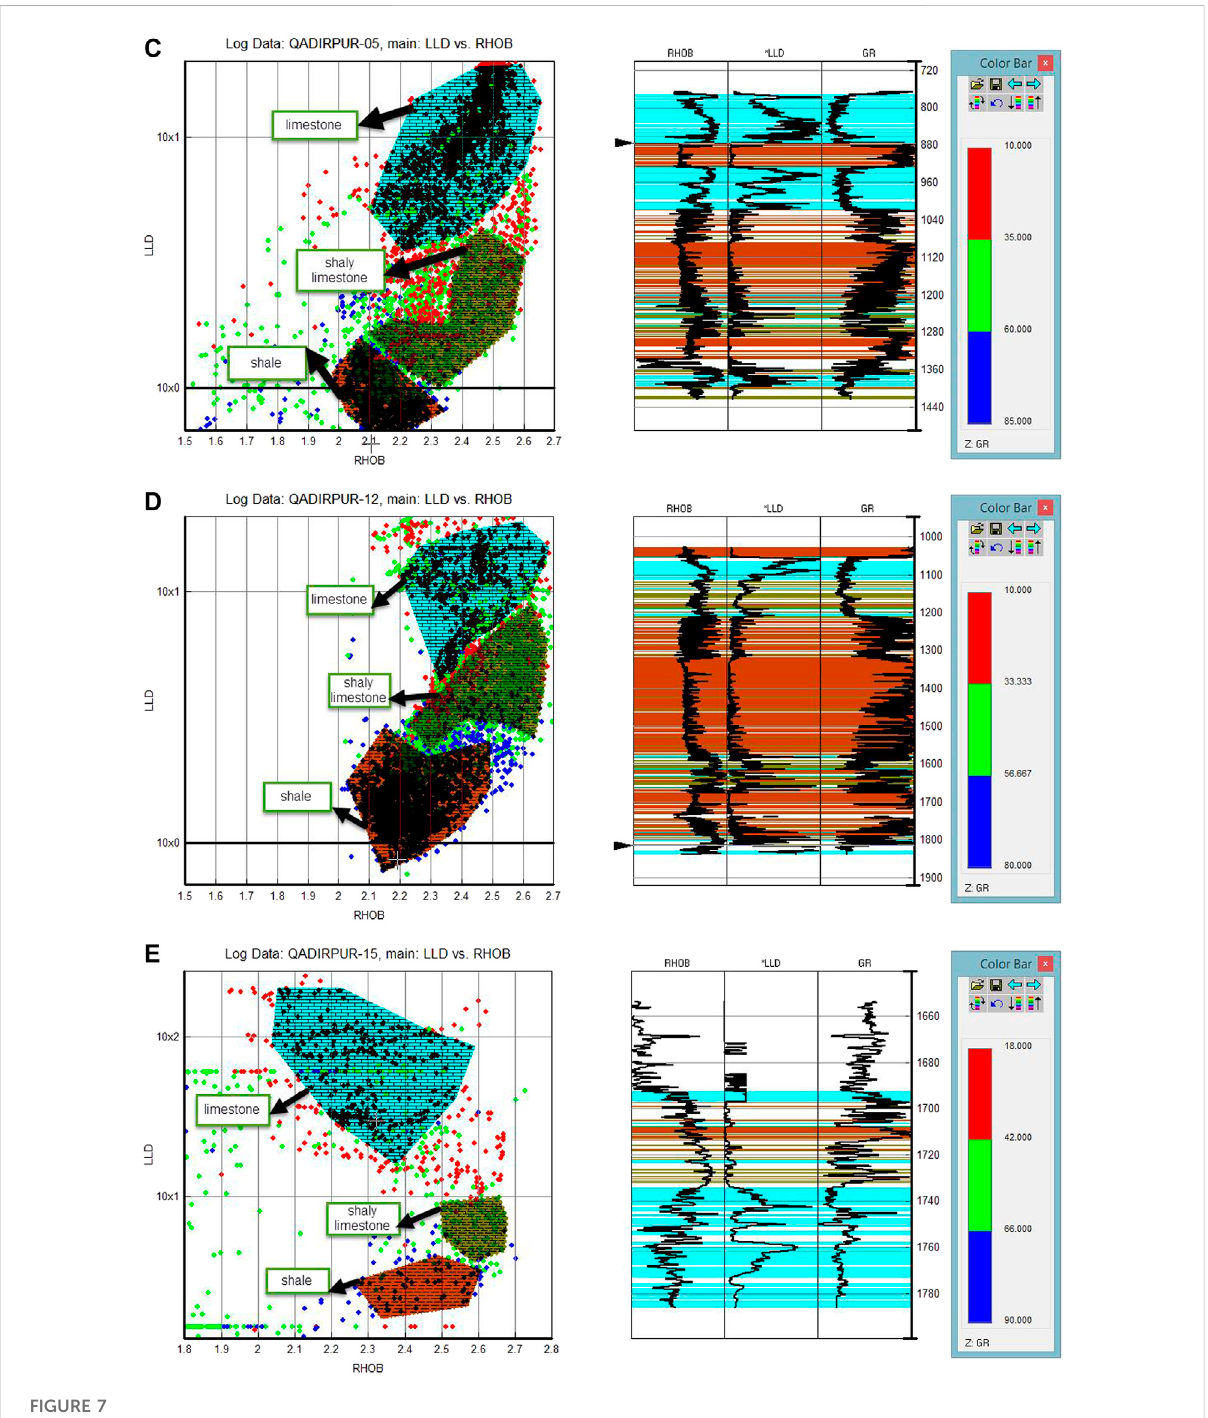
and hydrocarbon saturation of about 46%. In Q-05, two hydrocarbon- bearing zones are marked at a depth above 1360 m and below 1385 m (Figure 4C) with a slightly higher volume of shale (~36%), high porosity (~0.33), and low hydrocarbon saturation (~36%). The